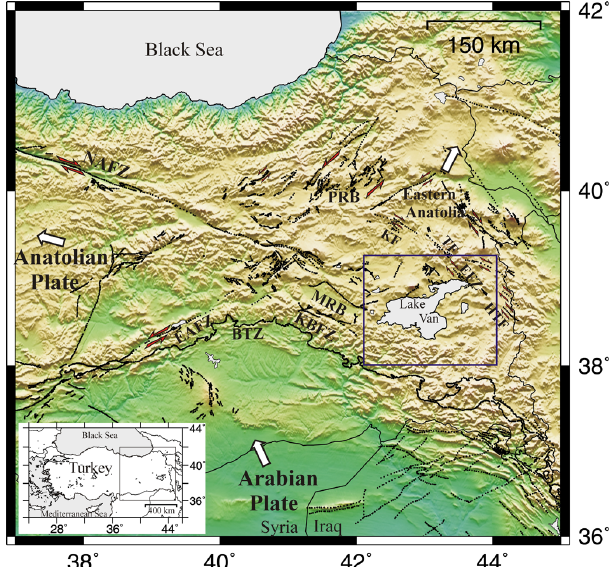
Fig. 1. Major tectonic elements of eastern Anatolia. Large rect- angle encloses the map areas shown in Figs. 2, 3 and 4 and large arrows indicate relative plate motions. Extent of faults and relative plate motions are from MTA (2012) and Reilinger et al. (2006), respectively. NAFZ – North Anatolian Fault zone, EAFZ – East